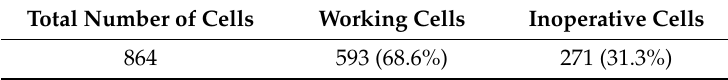
Table 2. Condition of the photocells before the modules are dehumidified.